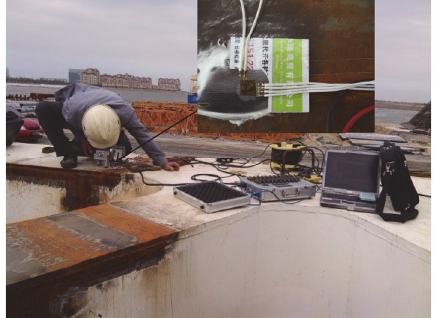
Figure 5: Hole-drilling